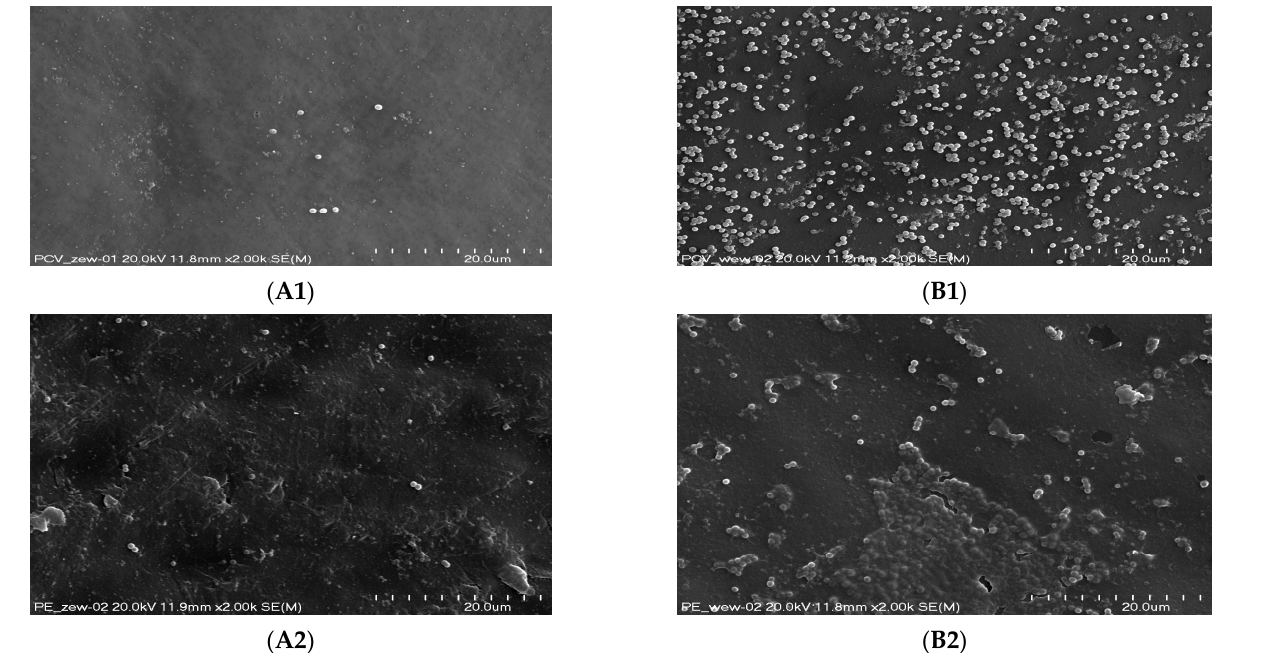
Figure 7. S. aureus microcolonies and biofilm exposed on the surface of a tracheostomy tube made of PVC ( 1 ) and PE ( 2 ) on the outer ( A ) and inner ( B ) sides. Magnification ( A1,A2,B1,B2 ): 2000×.